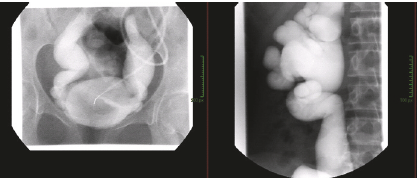
Figure 1: Retrograde cystography showing massive ureterovesical reflux and hydronephrosis.